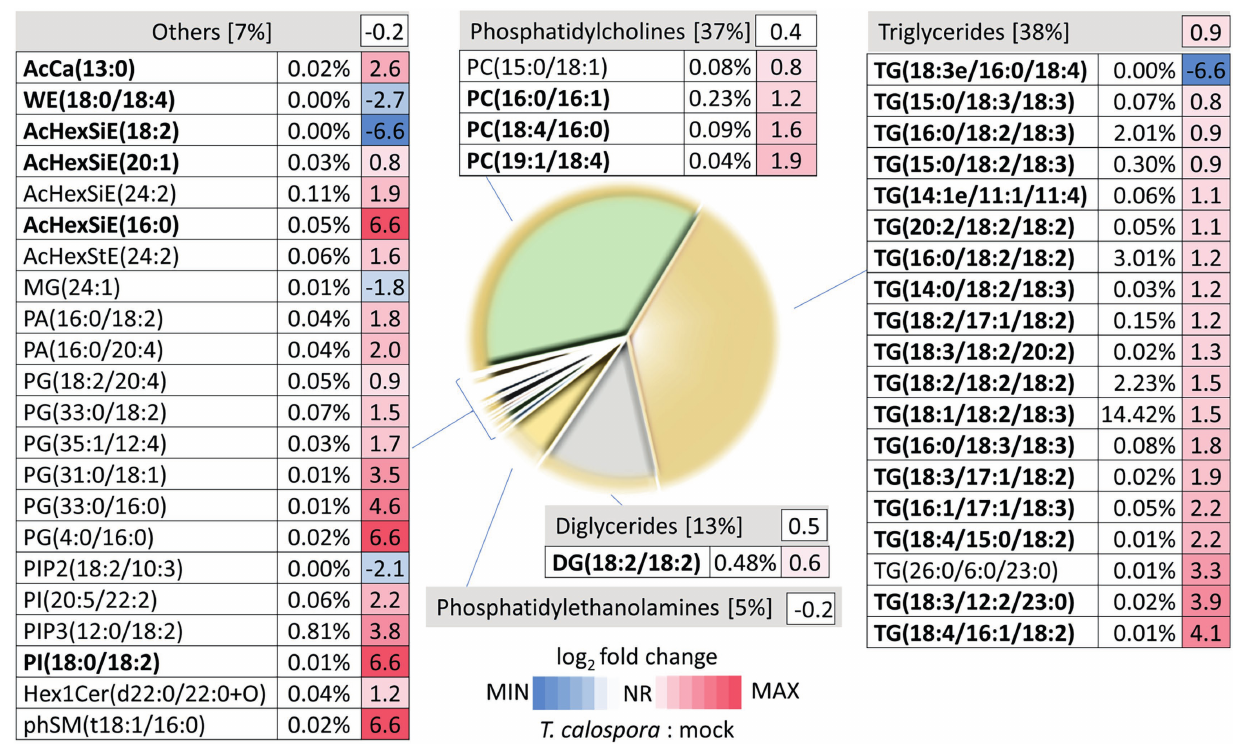
FIGURE 5 | Direct infusion analysis reveals changes in lipid composition after tuber inoculation Pie chart representation of inoculated tuber lipidome and heat map visualization of the fold changes of detected differentially abundant lipids. Percentages indicate estimated relative lipid abundances based on precursor ion intensities. Data represent the means of at least four biological replicates (tubers of four inoculated plants and five mock-treated controls). AcCa, acyl carnitine; WE, wax ester; AcHexSiE, AcylGlcSitosterol ester; AcHexStE, AcylGlcStigmasterol ester; DG, diglyceride; MG, monoglyceride; TG, triglyceride; PA, phosphatidic acid; PG, phosphatidylglycerol; PC, phosphatidylcholine; PI/PIP, phosphatidylinositols; Hex1Cer, Simple Glc series; and phSM, sphingomyelin. Compounds in bold represent high-scoring identifications as determined by LipidSearch 4.2. For details, see Supplementary Table S4